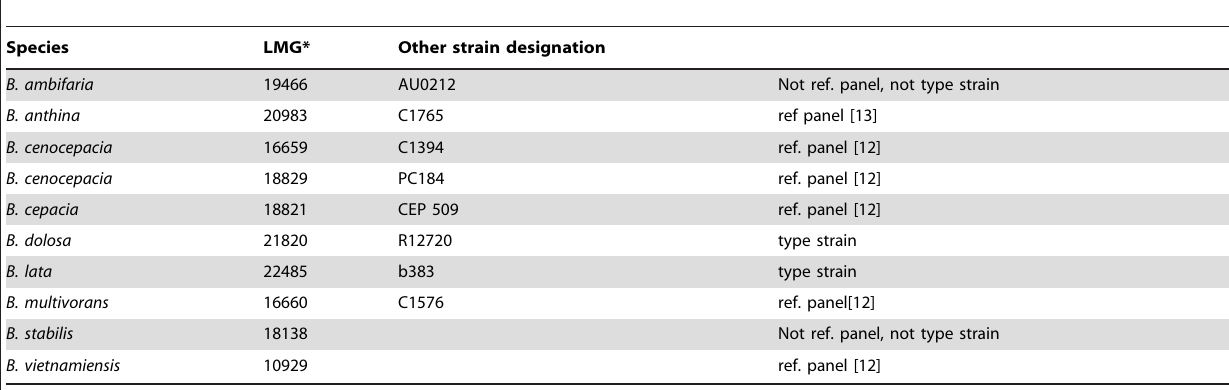
Table 1. BCC species investigated for the structure of their EPOLs